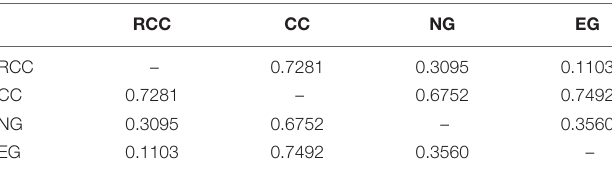
TABLE 3 | The average genetic distances between each pair of fish taxa included in this study: RCC, CC, EG, NG. RCC CC NG EG RCC